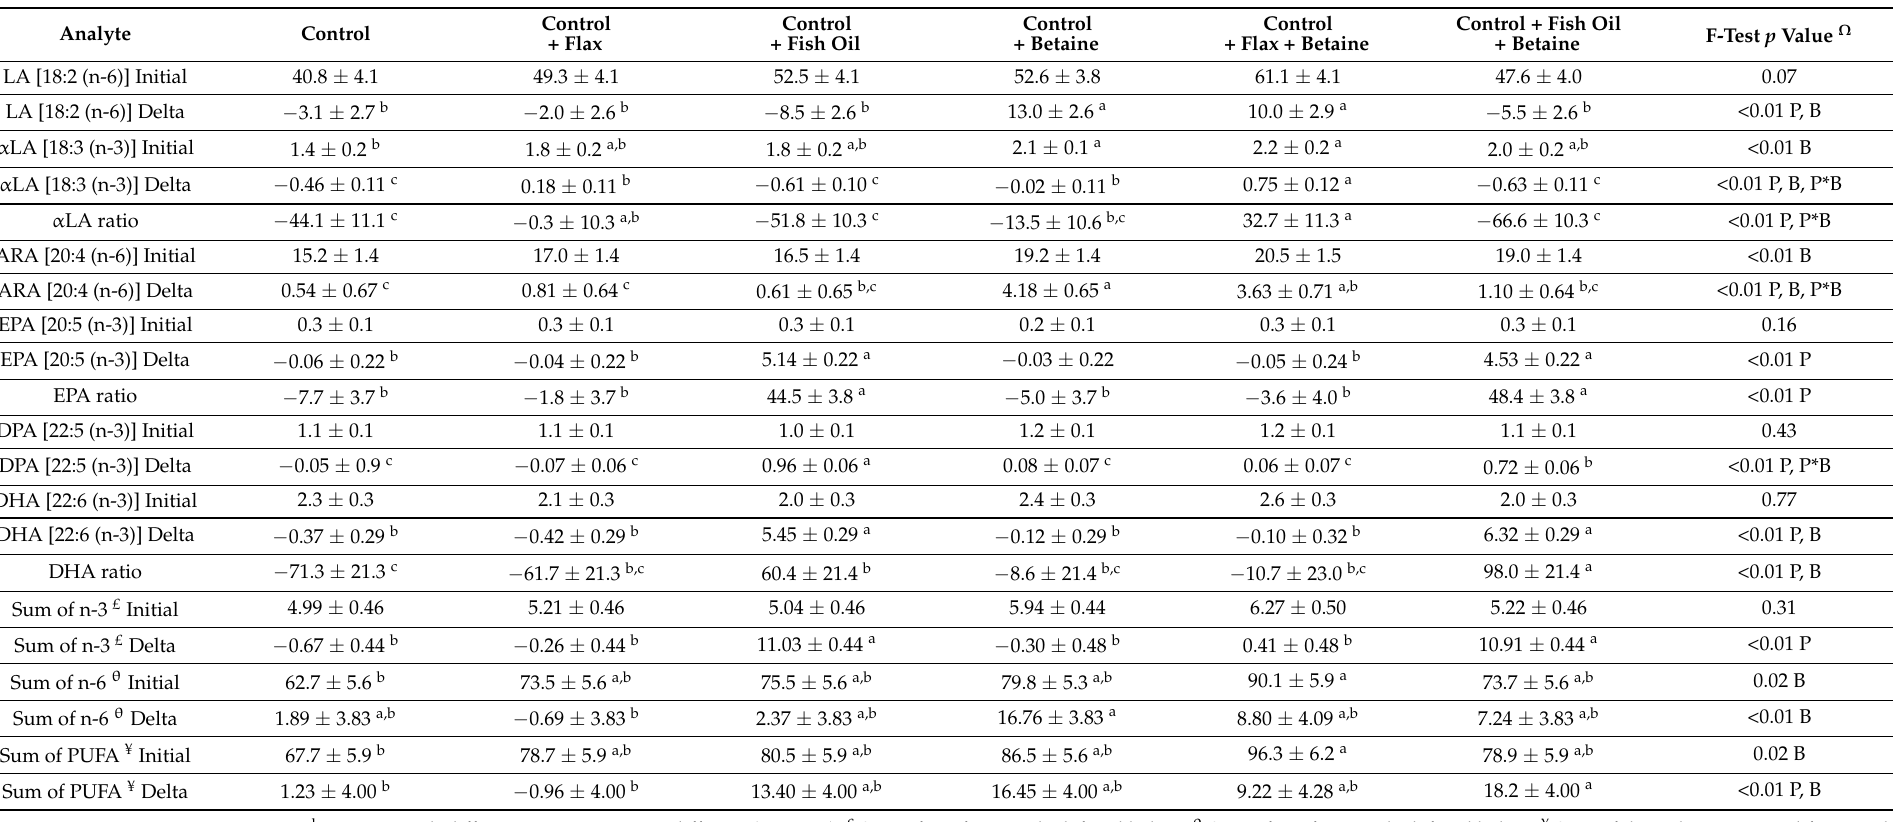
Table 3. Circulating concentration (mg/dL) of initial polyunsaturated fatty Acids, delta concentration over the course of the study (Final–Initial), or ratio of change in circulating fatty acid concentration divided by daily intake ( µ g/dL/mg daily intake). Values are lsmeans ± standard